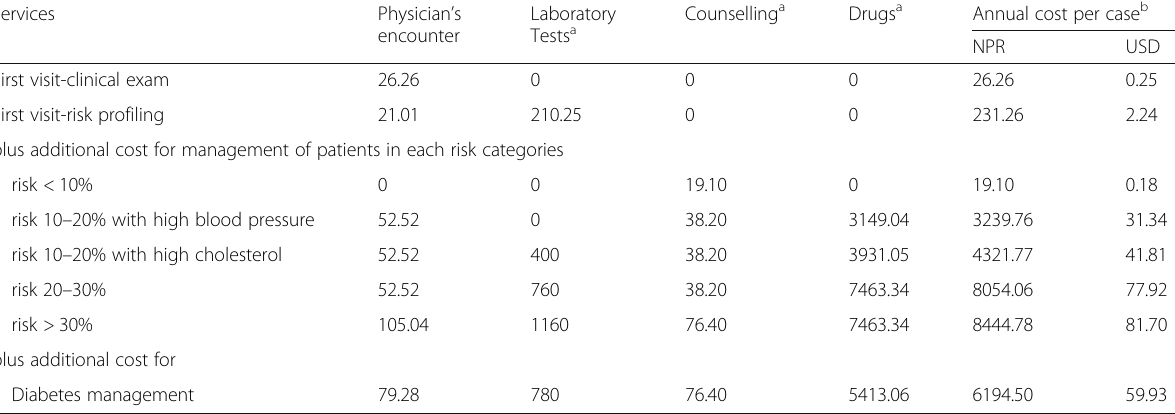
Table 5 Annual cost of treatment disaggregated by service type